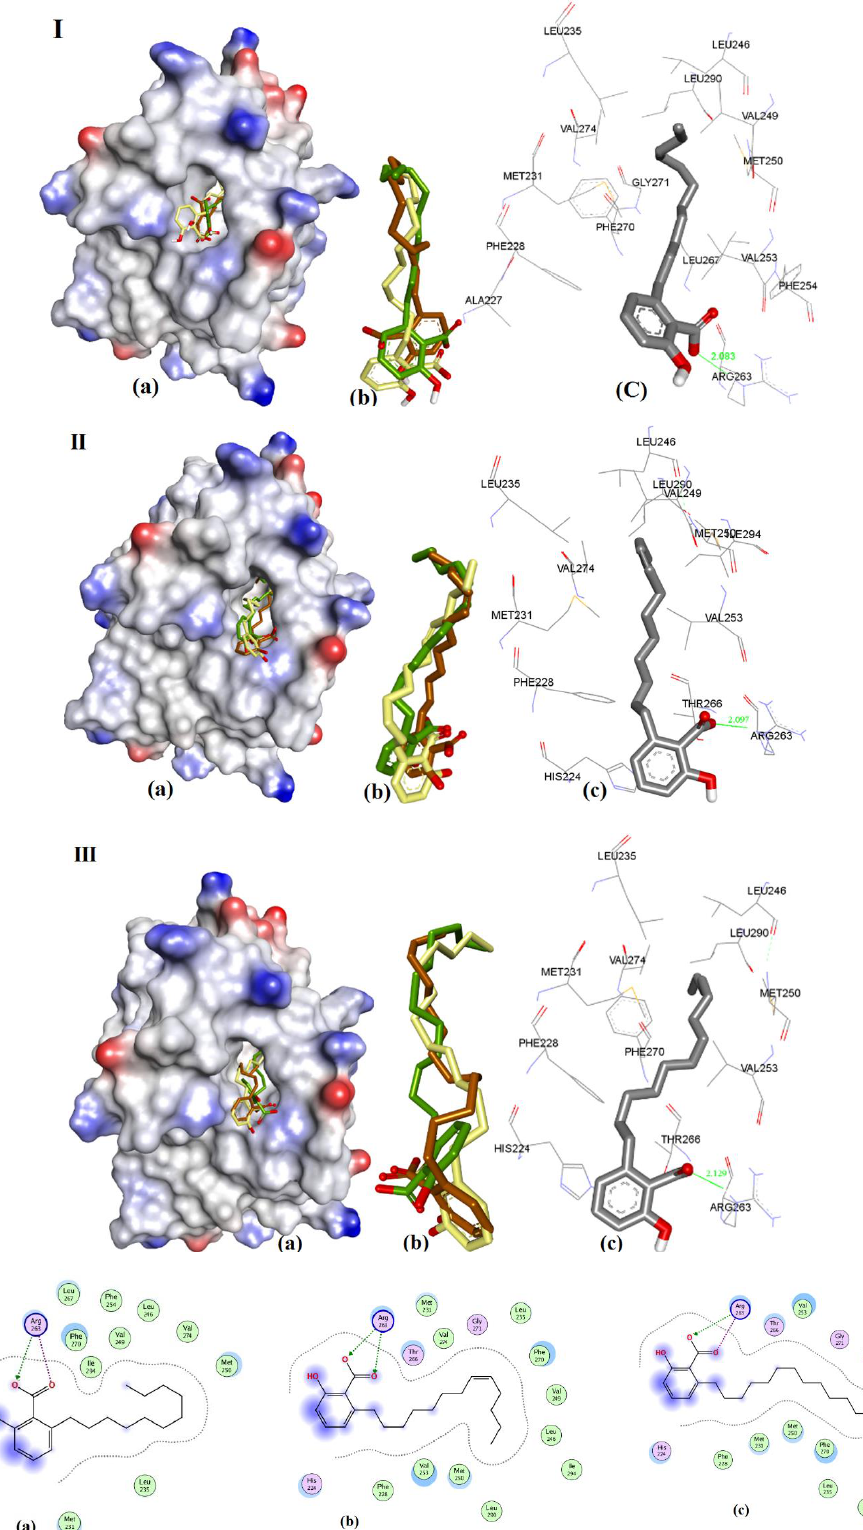
Figure 11. Representation of modeling for ( I ) 3d , ( II ) 3e , and ( III ) 3f : ( a ) The ionized solvent-exposed surface mapping of hMcl-1 along with the docked poses from MOE (in brown), AutoDock (in green), and VlifeDock (in yellow) show their fitting to the cavity. ( b ) Similar-pose ensemble clustering of all three poses was attained from the three different docking methods. ( c ) Binding mode of 3d/e/f . ( IV ) 2D interaction of 3d (LHS), 3e (Middle), and 3f (RHS). In case of 3g (IC 50 = 1.2 µM, ΔG = − 8.00 kcal.mol −1 ), when compared to 3e (IC 50 = 0.2 µM, ΔG = − 8.47 kcal.mol −1 ) and 3f (IC 50 = 0.2 µM, ΔG = − 8.22 kcal.mol −1 ), it has a longer